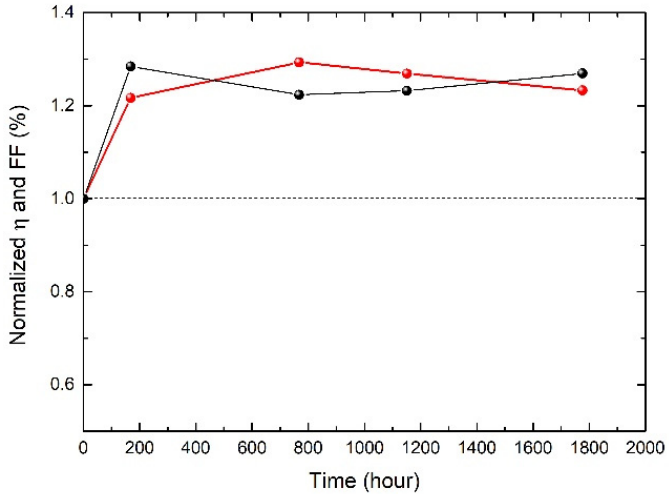
Figure 6. Shelf-life conditions (ISOS-D-1) of a DSSC module. The red line represents the PCE and the black line the FF.